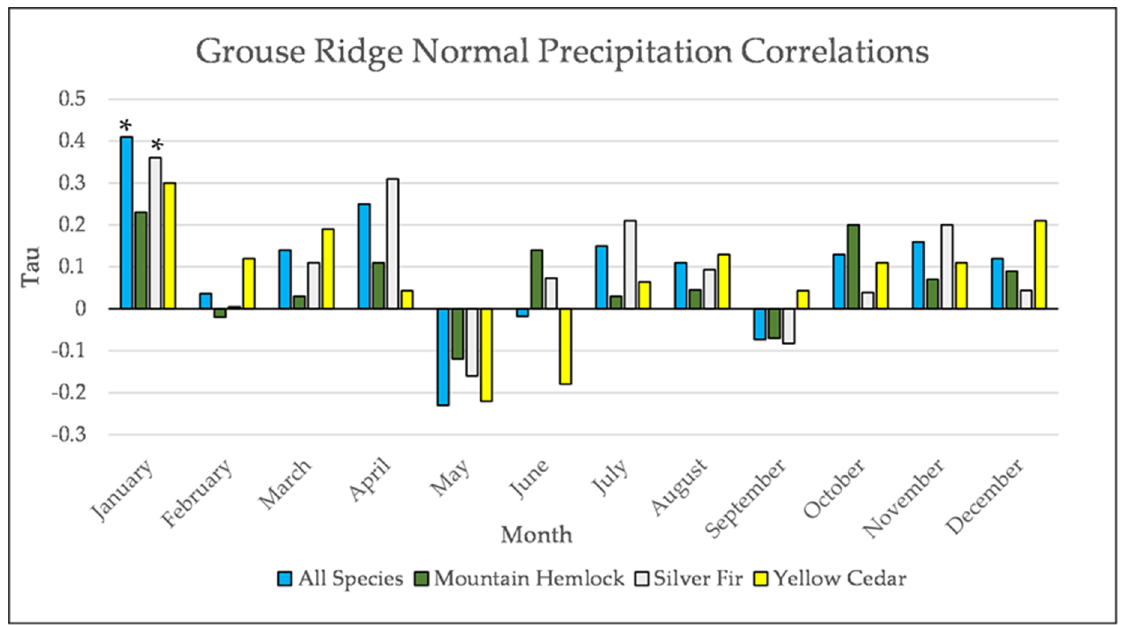
Figure A23. Normal Kendall’s correlation between mean monthly precipitation and establishment at the Grouse Ridge site. * = p -Value < 0.05.